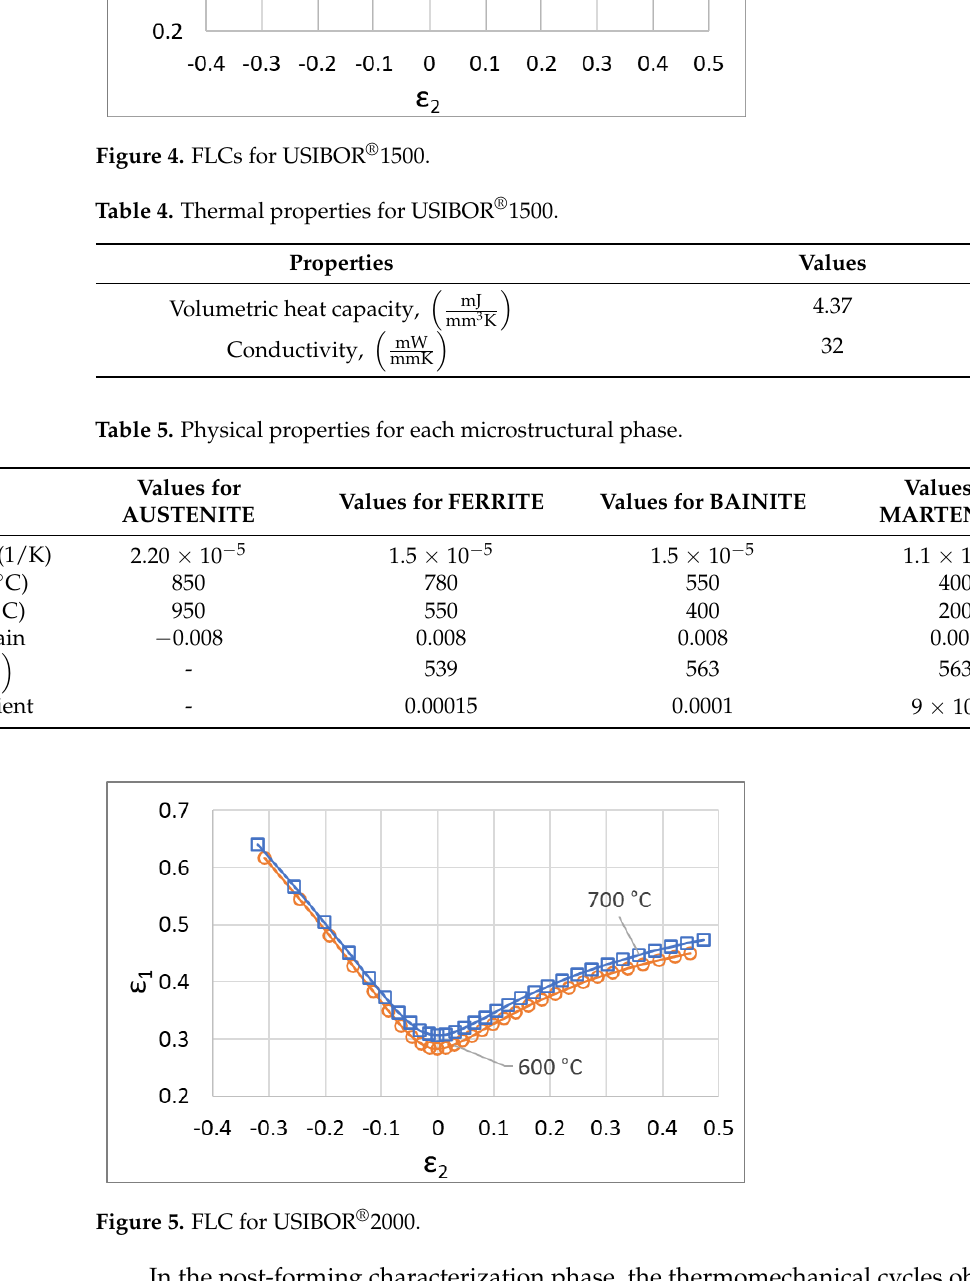
Table 5. Physical properties for each microstructural phase.